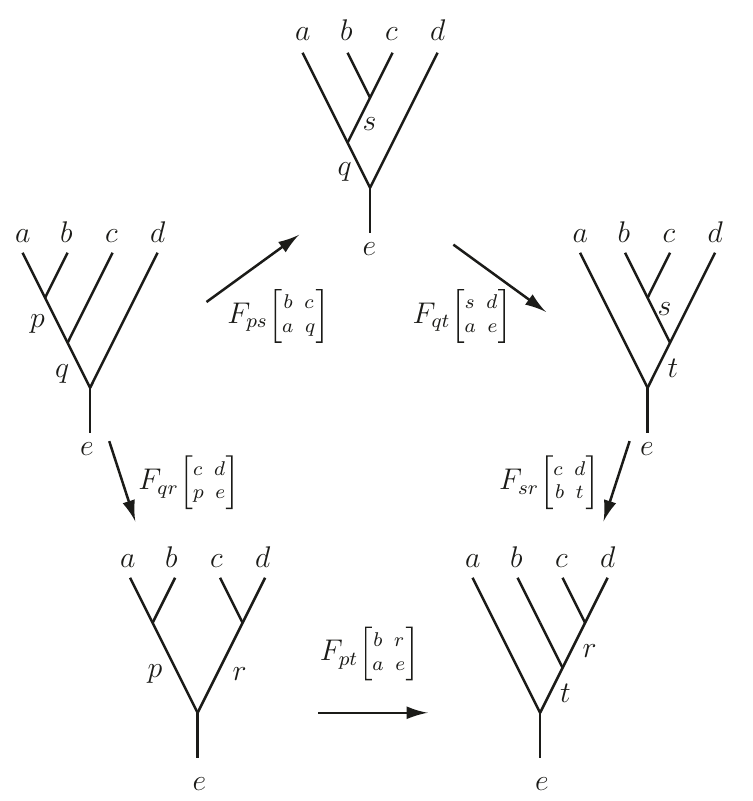
Figure 4 . Pentagon identity as a consistency condition for fusion of